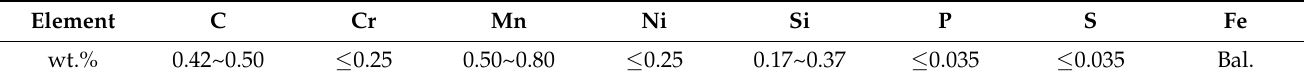
Table 2. Chemical composition of 45